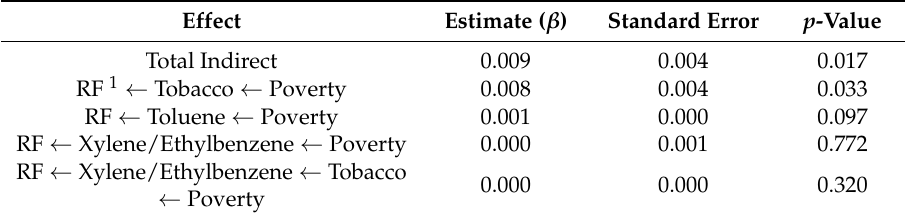
Table 4. Indirect effects of poverty on respiratory